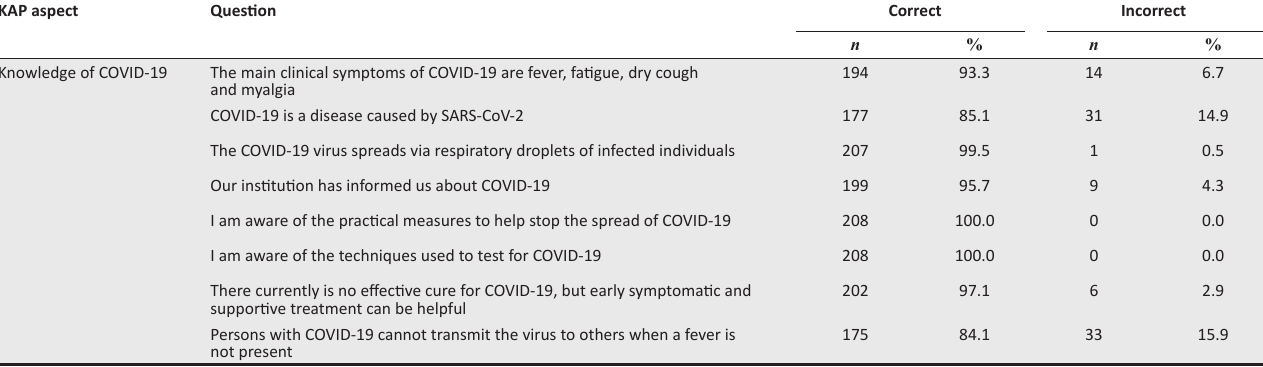
TABLE 2 : Characteristics of responses for knowledge and practice towards COVID-19, Zambia, June 2020. † KAP